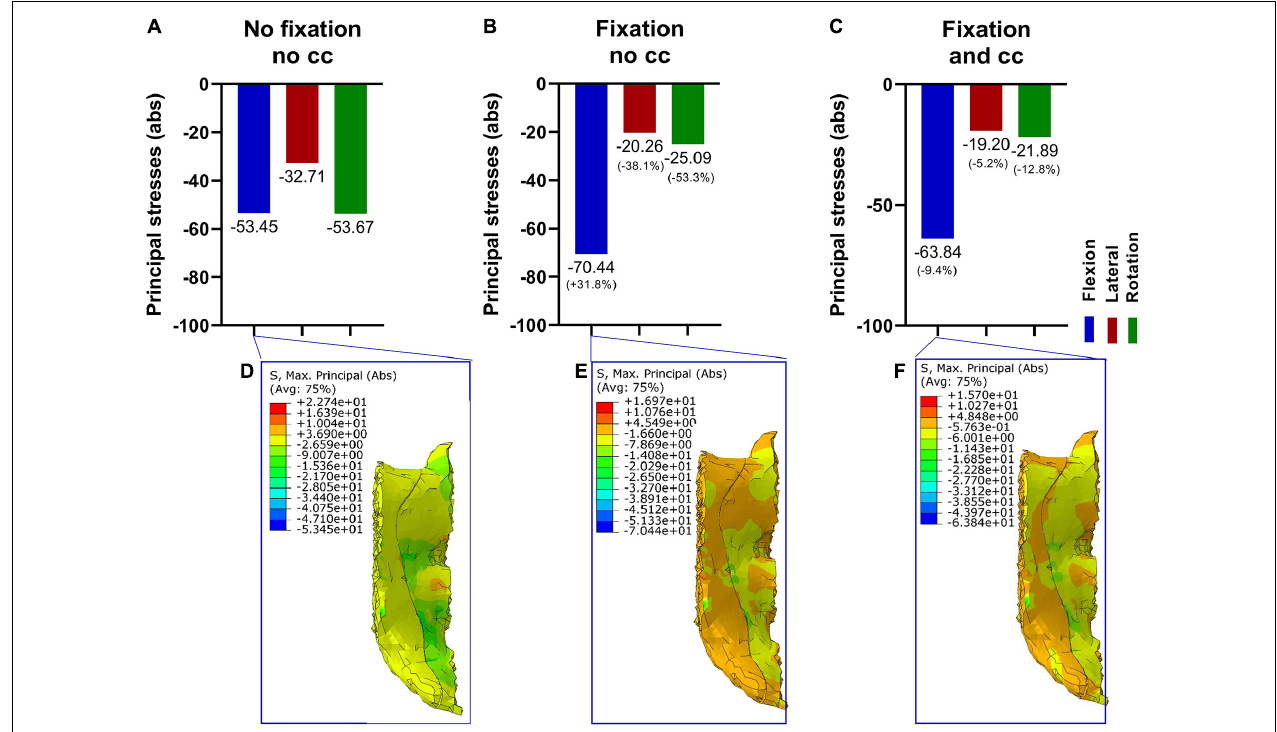
FIGURE 6 | Maximum principal stresses (absolute values) in the fracture area (A–C) and corresponding stress distribution exemplarily depicted in the flexion situation (D–E) . The fixation alone reduced the maximum stresses in lateral bending and rotation (A,B,E) , and a cross connector further reduced the occurring maximum stresses in all loading cases (C,F)